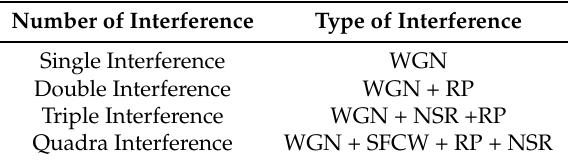
Table 3. Common EMI combinations.